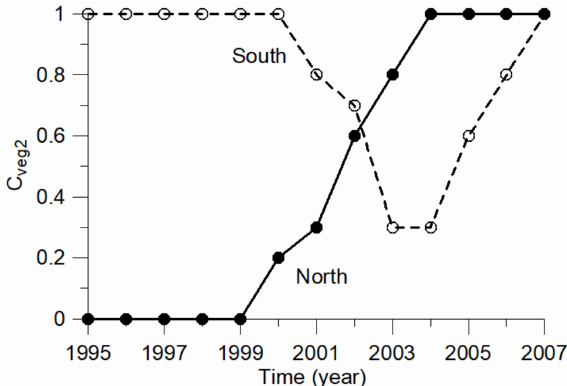
Figure 12. Time series of C veg2,N and C veg2,S .